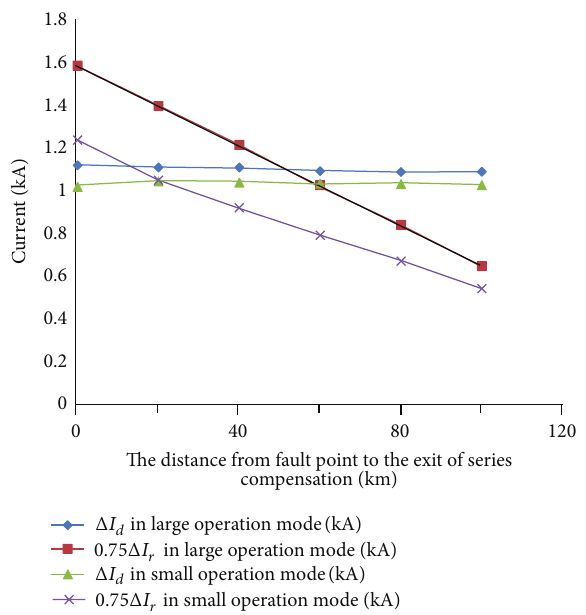
Figure 2: The relationships of Δ𝐼 𝑑 and 0.75Δ𝐼 𝑟 when the single phase grounding fault with 300 Ω transition resistance occurred at different places on the line BC.